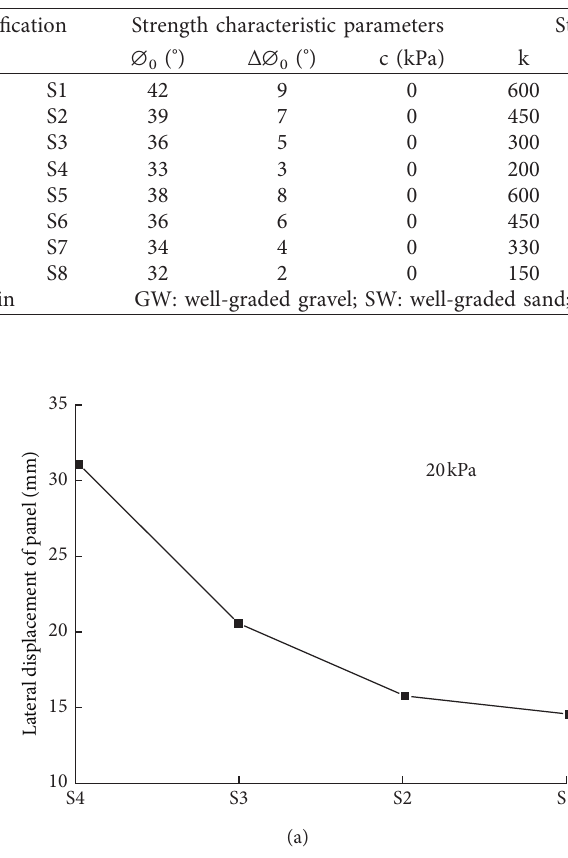
Figure 7: (a) Variation of lateral displacement of face slab with different backfill (S1–S4). (b) Variation in the lateral displacement of the panel with different backfill